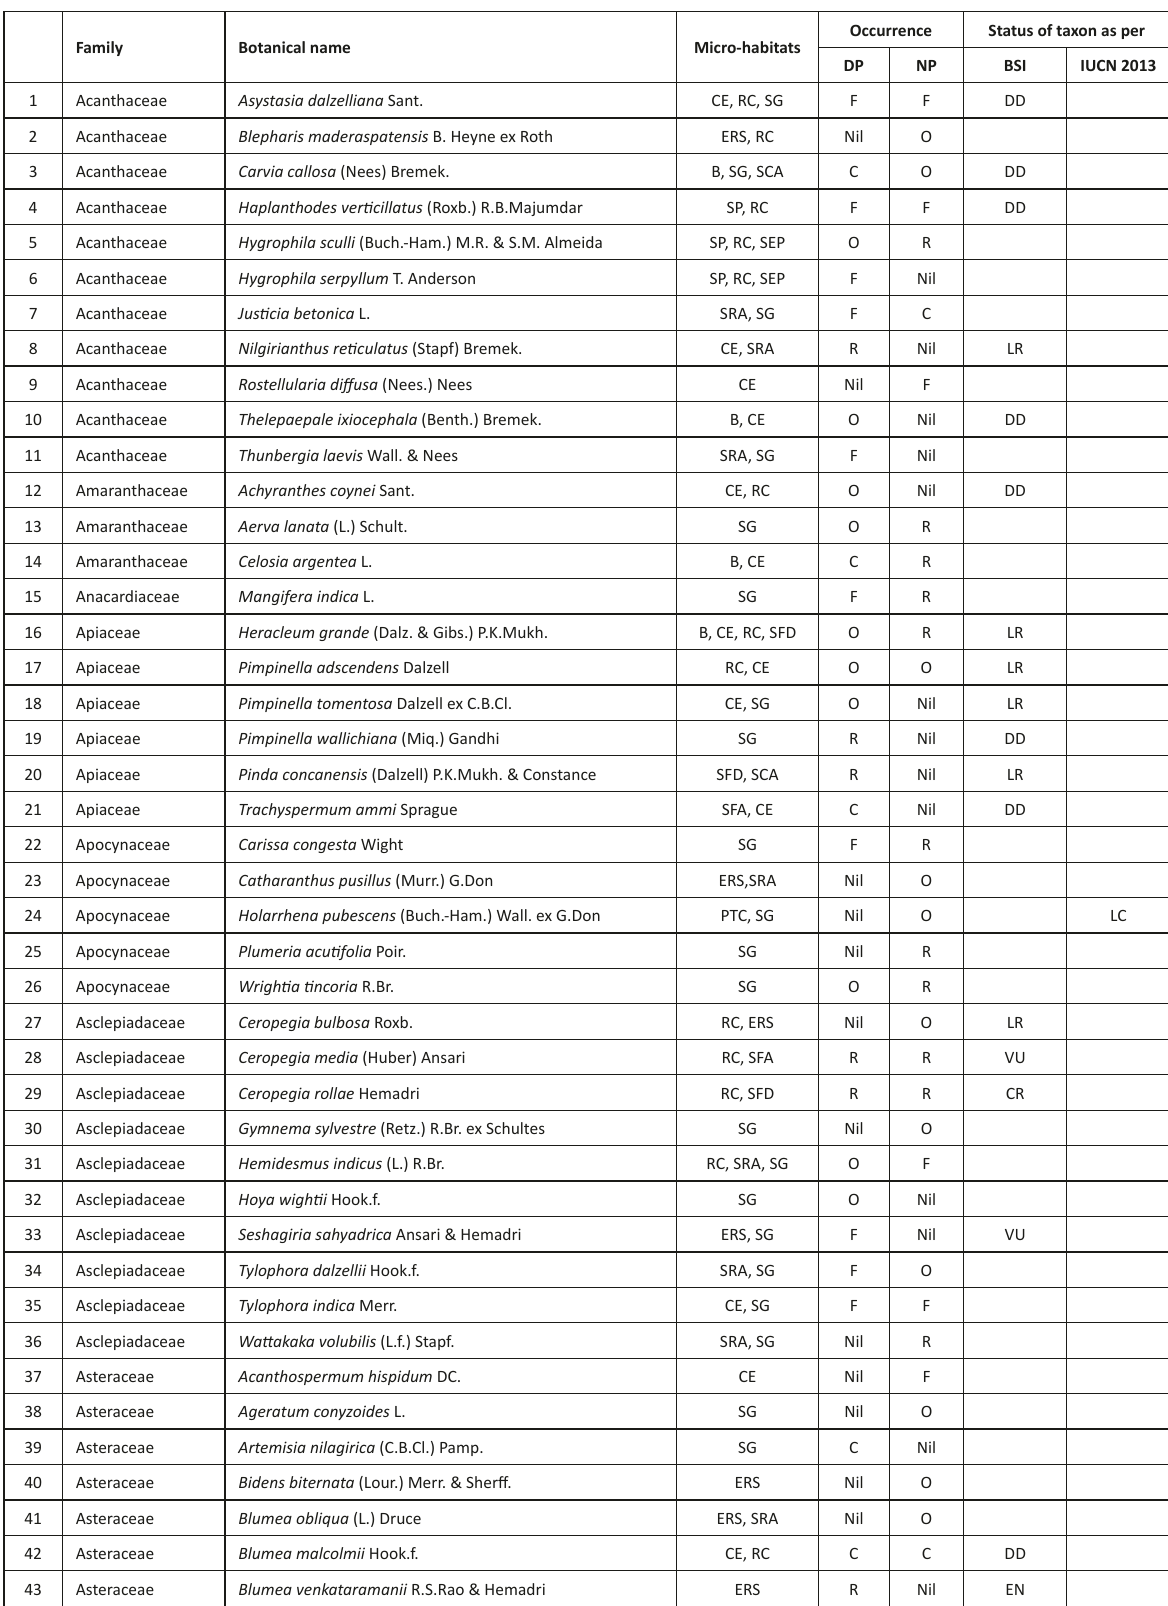
Table 1. Species list from two outcrops, Durgawadi Plateau (DP) and Naneghat Plateau (NP). Family Botanical name